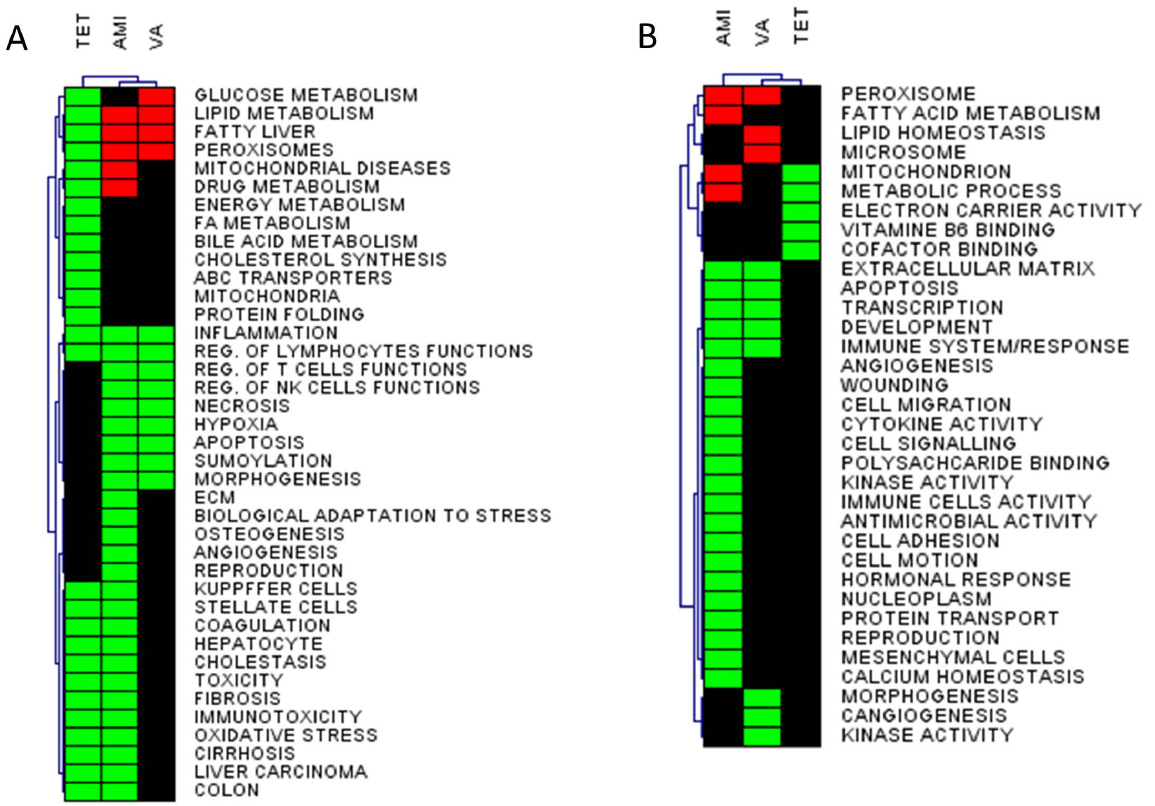
Figure 2. Effects of steatogenic drugs on gene expression in mouse PCLS. A. PCLS obtained from 5 mice were treated with 50 m M amiodarone (AMI), 200 m M of valproic acid (VA), 40 m M of tetracycline (TET) or vehicle for 24 h and subjected to Affymetrix microarray analysis. The biological processes in the heat map correspond to gene sets significantly affected according to GSEA (p , 0.05, FDR , 0.05). Processes that were upregulated are represented by red colour, the downregulated processes are depicted in green, and unaffected processes in black. B. Gene Ontology (GO) analysis of the significant genes identified by GSEA (p , 0.05, FDR , 0.05) was performed in DAVID. GO terms were considered to be significant if p , 0.005, FDR , 0.005. The significant GO terms were grouped into GO annotation clusters and are depicted as a heat map. For explanation of the colours see Figure 2A.